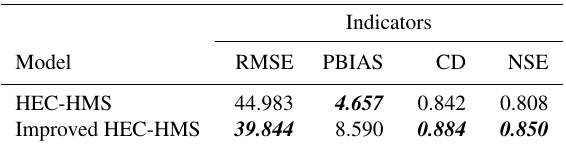
Table 3. Calibrated HEC-HMS model result comparisons. Bold italic font indicates a better result.